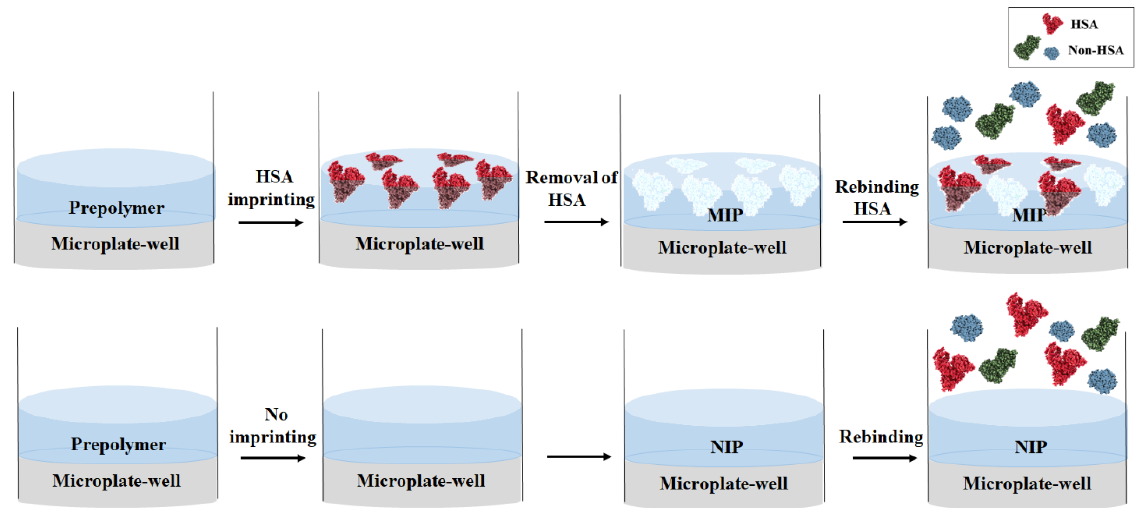
Figure 1. Schematic representation of HSA-MIP-based microplate fabrication. However, the analyte binding events to the MIP-coated microplate did not produce any directly measurable signals. Therefore, a chemical colorimetric assay was combined with the binding assay for indirect detection. To investigate the efficiency of imprinting, the bound HSA on the MIP surface in the microplate was assessed using the Bradford reaction coupled with UV–vis spectrophotometry. The measurement procedure of the bound protein on the polymer surface was modified based on the conventional method, determining the proteins in solution. Briefly, 100 µ L of HSA standard at a concentration of 10 g/dL was added to the MIP wells and incubated for 15 min. The HSA solutions were then discarded and the wells were washed with DW three times to remove non-selectively bound molecules. This was followed by adding 200 µ L of Bradford reagent and incubating at room temperature (25 °C) for 5 min as shown in Figure 2. The Bradford reagent containing Coomassie Brilliant Blue G-250 dye under acidic conditions can bind to the basic and aromatic amino acid residues of the surface part of the bound HSA on the MIP surface. The reactivities of the dye towards the bound and free protein in solution are different due to their different shapes. Therefore, the two species lead to somewhat different color responses. These differences relate to the number of amino acids that can react with the dye. The reagent color shifts from 465 nm (reddish brown) to 595 nm (blue) in the presence of proteins. Since the amount of the blue form is proportional to the amount of HSA bound to MIP, one can determine the quantity of bound HSA directly by measuring the absorbance at 595 nm with a Multiskan TM microplate spectrophotometer (Thermo Fisher Scientific, Waltham, MA, USA). In addition, 10 mM PBS without HSA was added to the